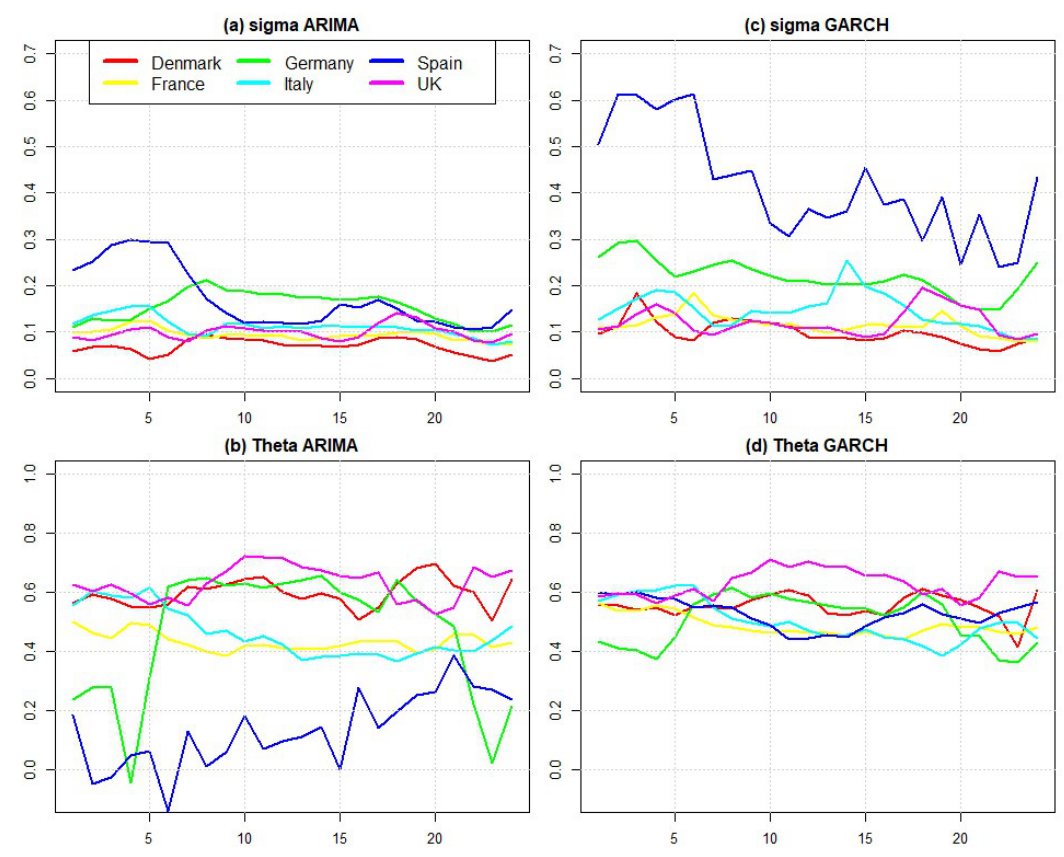
Figure 6. σ and 𝜃 estimates for ARIMA and GARCH models. Figure 6. σ and θ estimates for ARIMA and GARCH